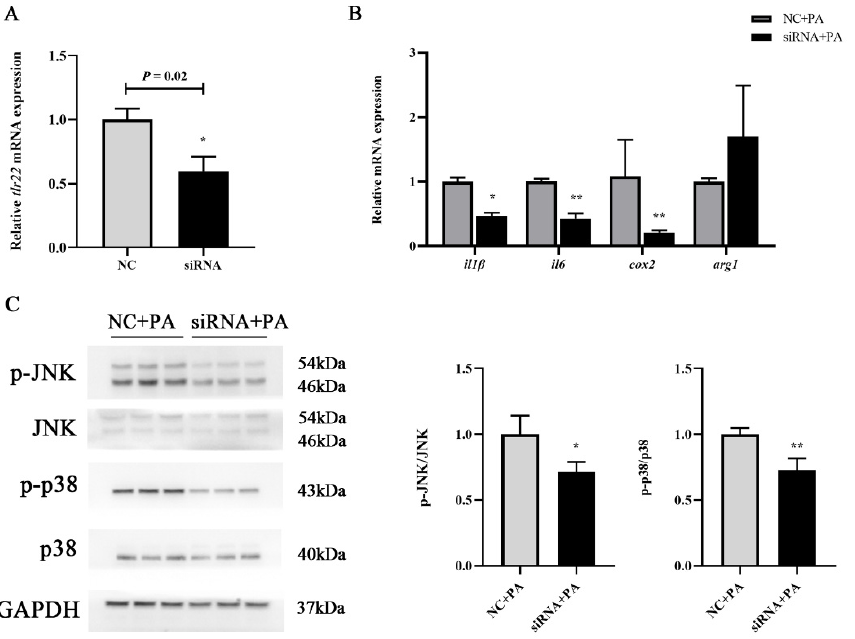
Figure 3. Effects of tlr22 knockdown on PA-induced inflammation in macrophages. ( A ) The mRNA expression of tlr22 after tlr22 knockdown. ( B ) Effects of tlr22 knockdown on the mRNA expression levels of inflammatory genes induced by PA. ( C ) Effects of tlr22 knockdown on the phosphorylation of the MAPK pathway induced by PA. The ratios of p-p38 to p38 and p-JNK to JNK were determined. The data are presented as the means ± SEM ( n = 3) and are analyzed using independent t -tests. * p < 0.05 and ** p < 0.01 indicate significant differences compared with the control group.